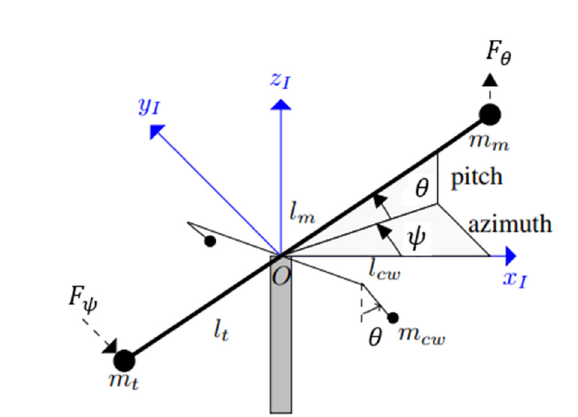
Fig. 1: Inertial Reference Frame of TRAS [14] For the purposes of mathematical modelling, a right- handed coordinate system is located at the pivot point of beam. Origin of the coordinate system is denoted by . The distance of tail and main rotors from the origin is denoted by l t and l m respectively. Whereas m m and O m t represent the counterweights at the main and tail of the beam. Moreover, represent the the levers respectively. The nonlinear model of